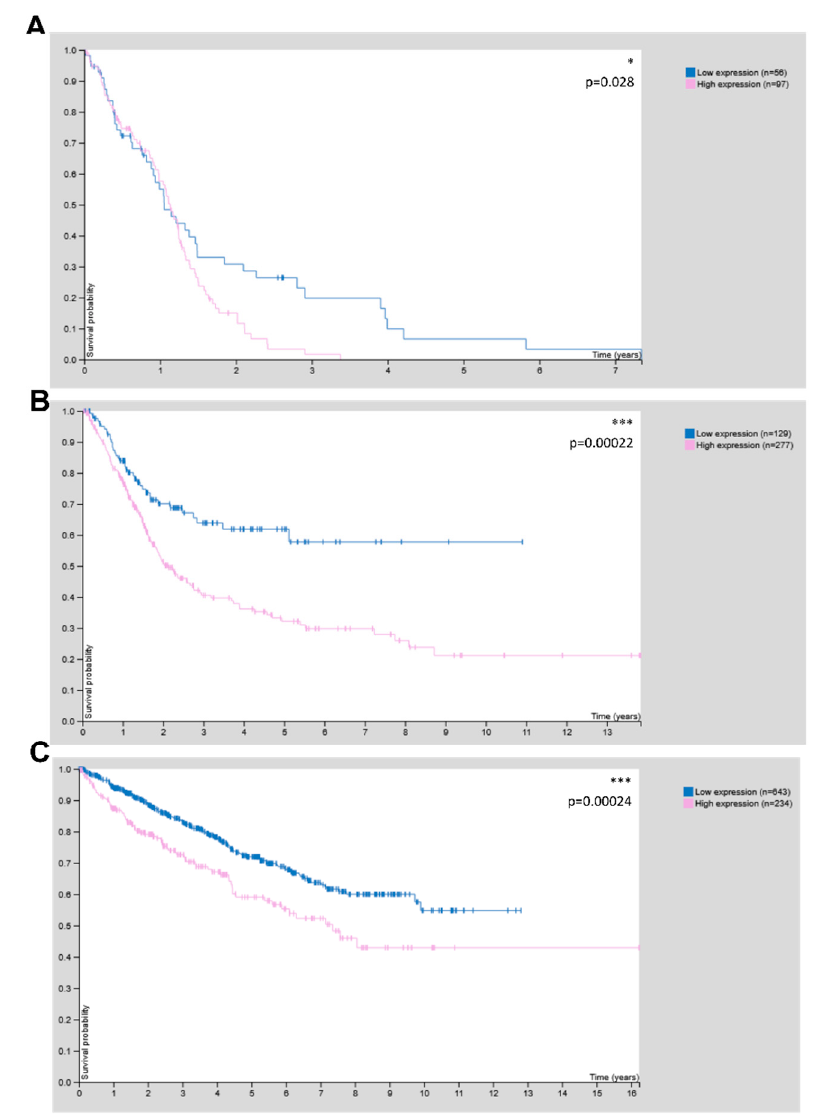
Figure 8. CHRDL1 is associated with worse survival in glioma and ( A ) An unfavourable prognosis in ( B ) urothelial and ( C ) renal cancer. According to data from the human protein atlas [37] (proteinatlas.org). * p < 0.05; *** p < 0.001; log-rank p -value for Kaplan–Meier plot. Image Credit: Human Protein Atlas.